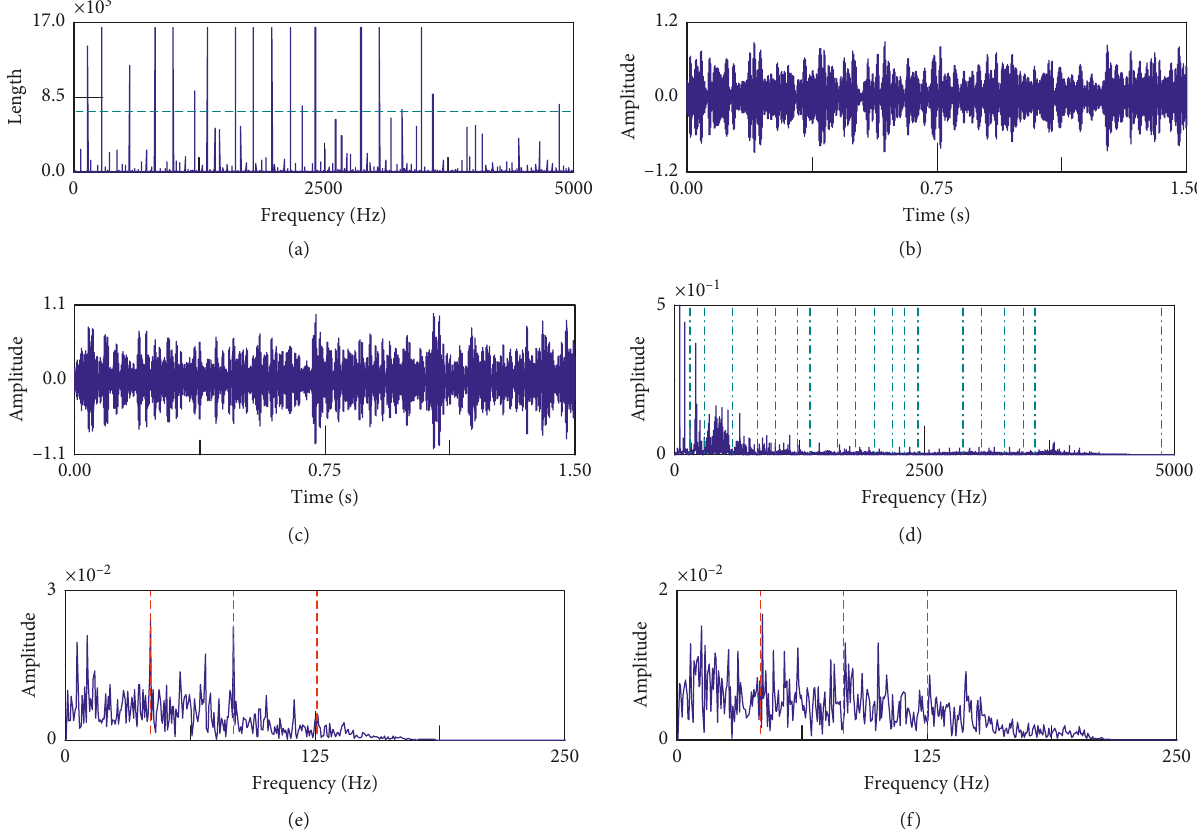
Figure 18: Results obtained by the traditional EWT: (a) SSP (green dashed line: the detected threshold by k -means clustering), (b, c) sub- band signals; (d) detected boundaries (green dash-dotted lines); (e, f) squared envelope spectra (red dashed lines: f BPFO and its